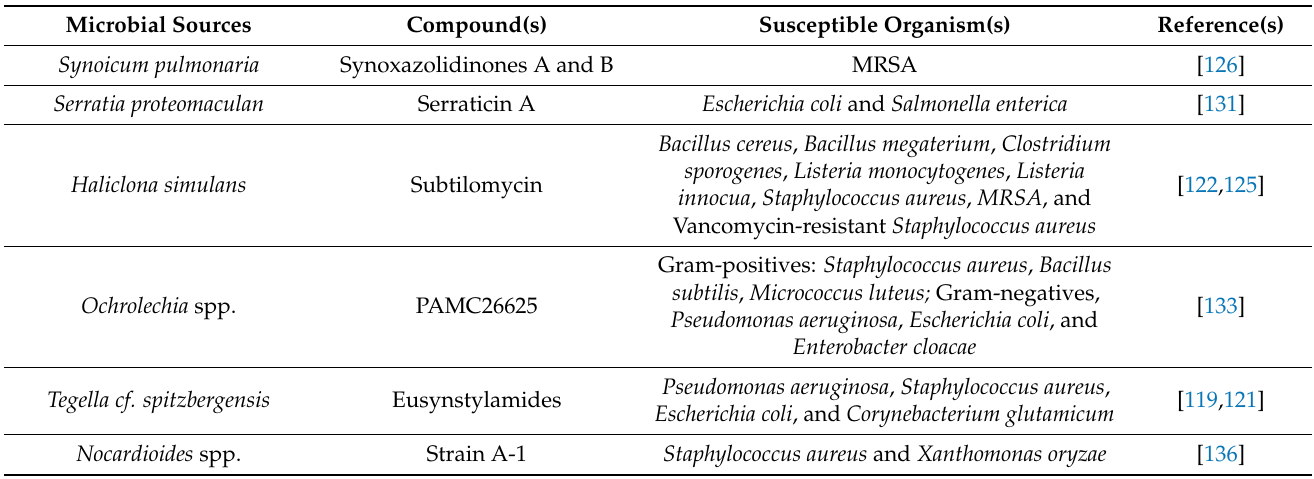
Table 5. Other sources of antimicrobial